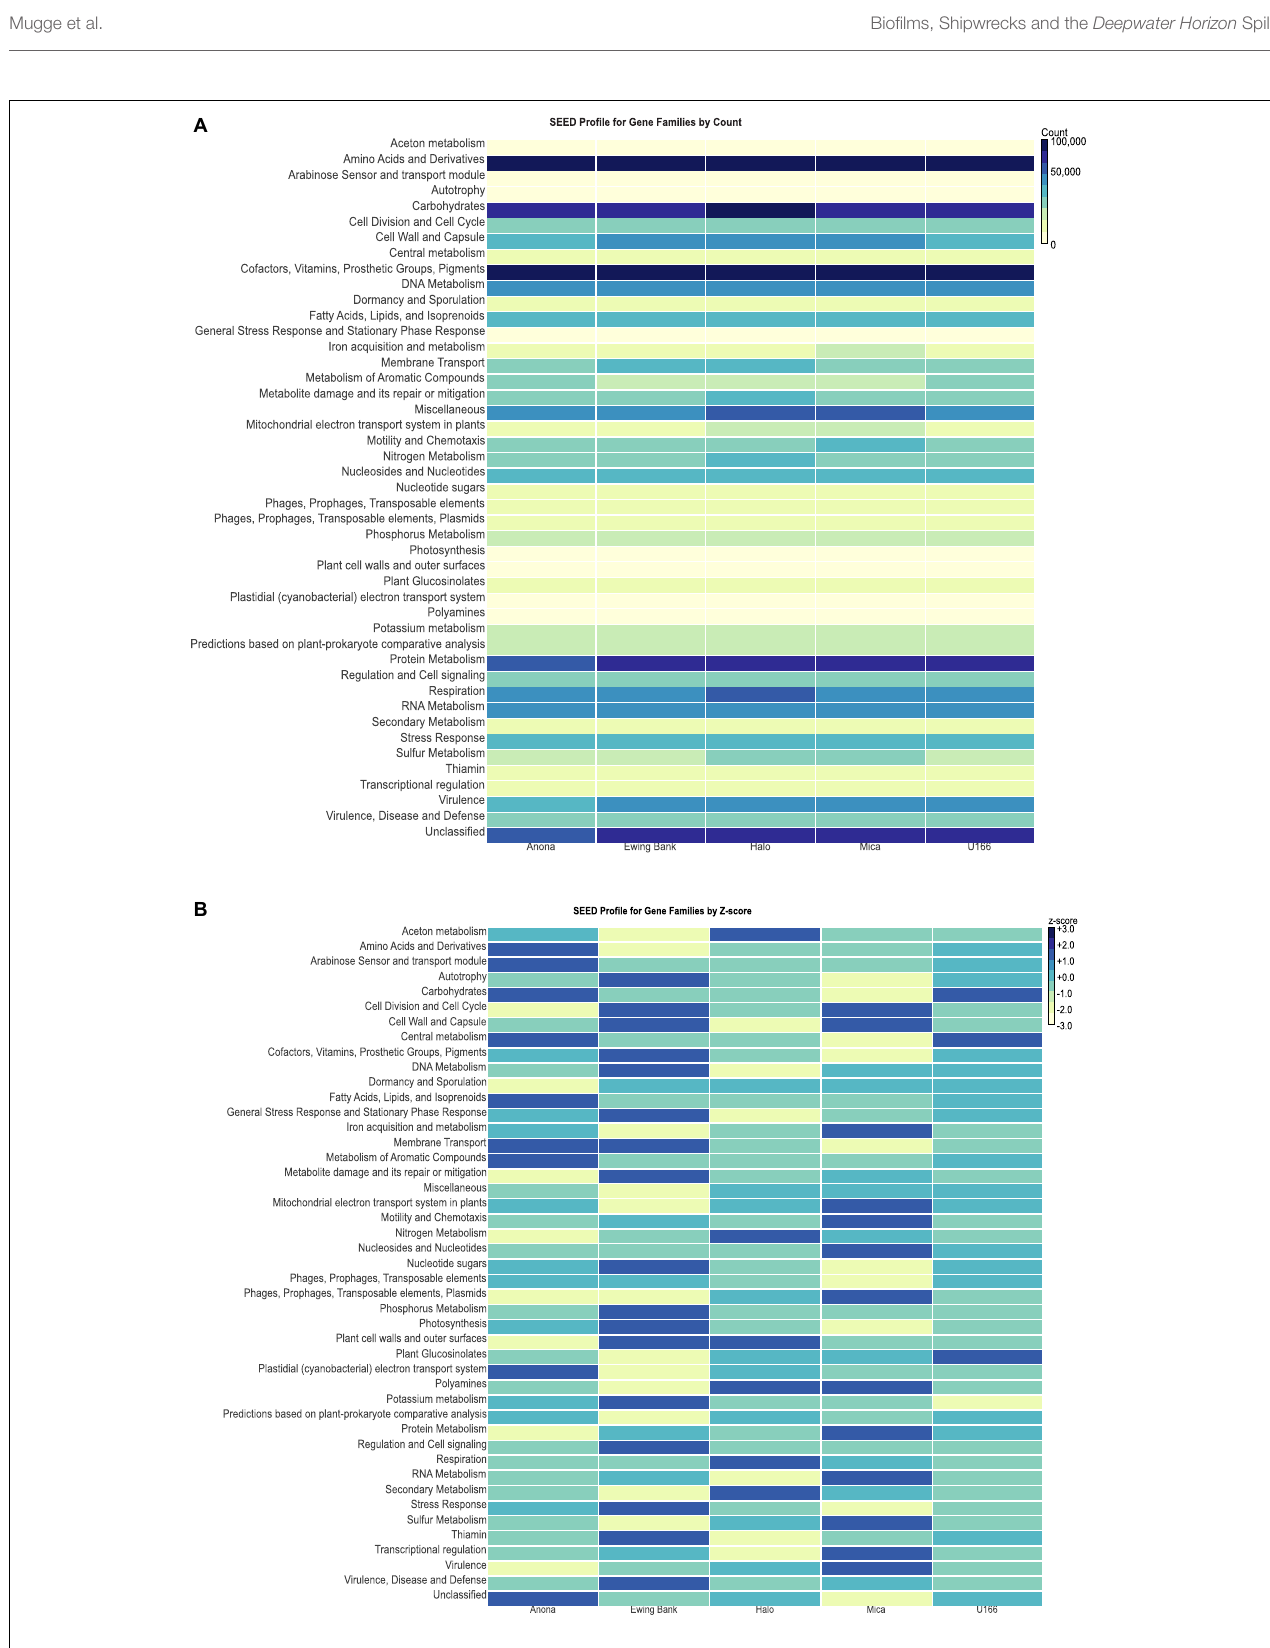
FIGURE 6 | MEGAN heatmaps of functional gene families classified using the SEED database. (A) Heatmap by count of gene reads in each family. Light colors represent smaller counts while dark colors represent larger counts. (B) SEED profile of gene families normalized by Z-score.